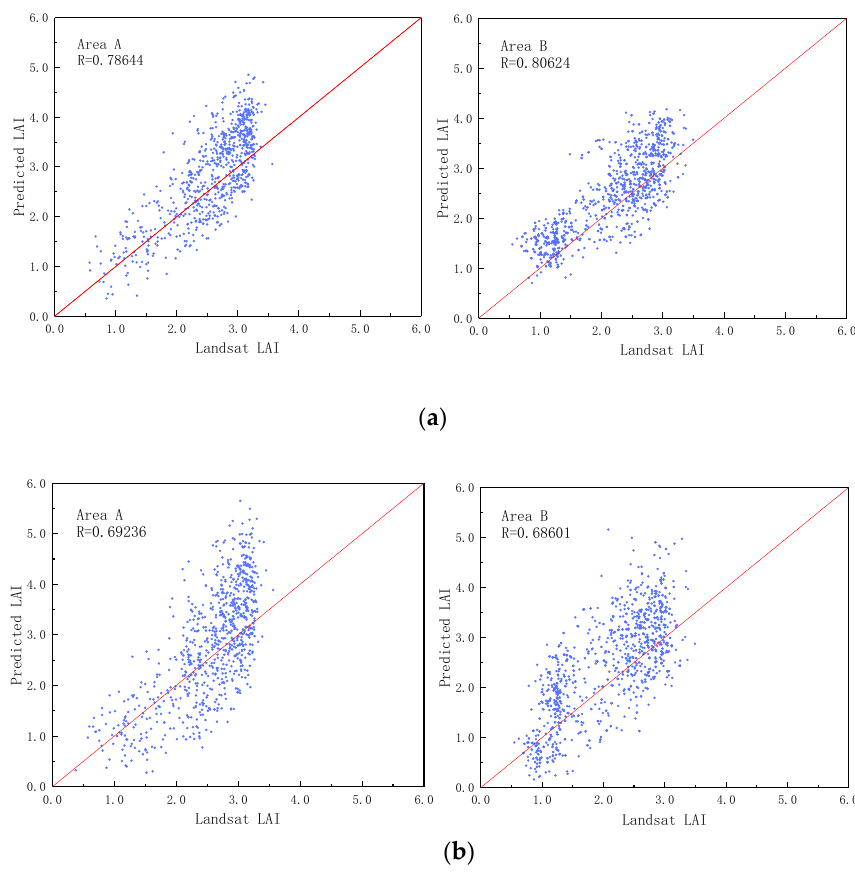
Figure 7. Correlation between the predicted LAI using different fusion models and Landsat LAI. ( a ) Improved FSDAF method; ( b ) FSDAF method. (red line is the 1:1 line). Table 2. Comparison of the standard difference (SD) of LAI data from different images.